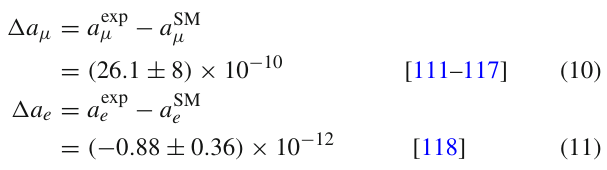
Table2 Fermionassignmentsunder SU ( 3 ) C × SU ( 3 ) L × U ( 1 ) X × U ( 1 ) L (cid:2) L L = L 1 ( L ) , L 2 ( L )